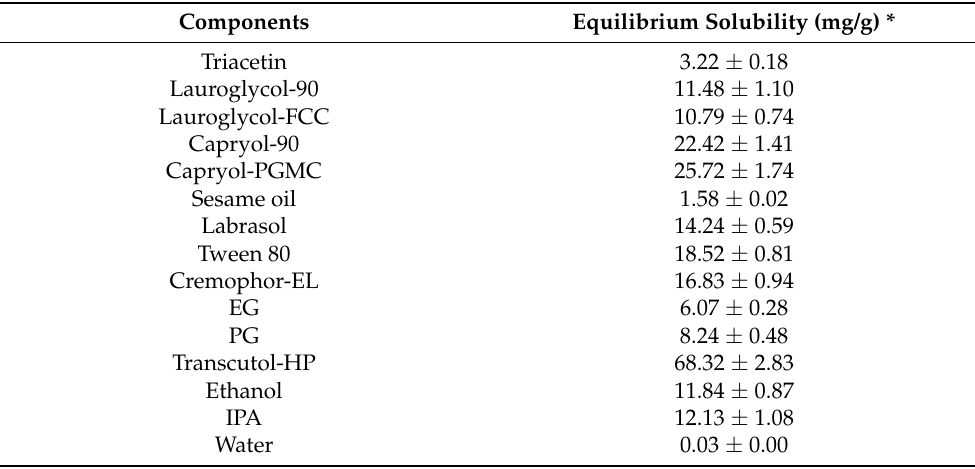
Table 1. Equilibrium solubility data of luteolin (LUT) in different excipients at 25 ◦ C.